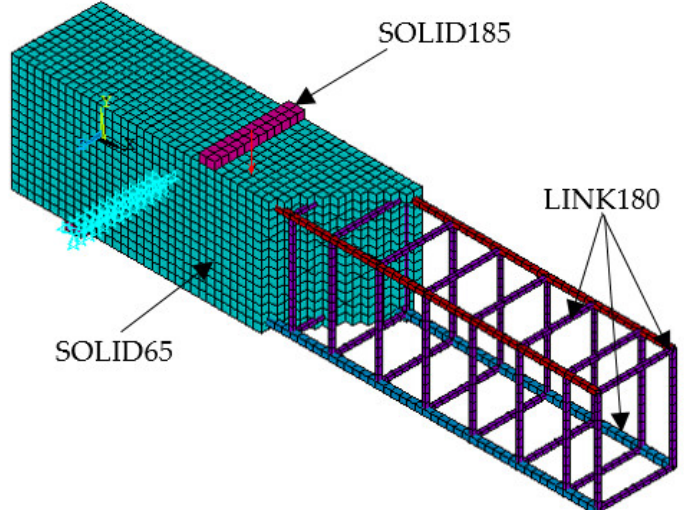
Figure 4. The Simulations of beams on ANSYS.